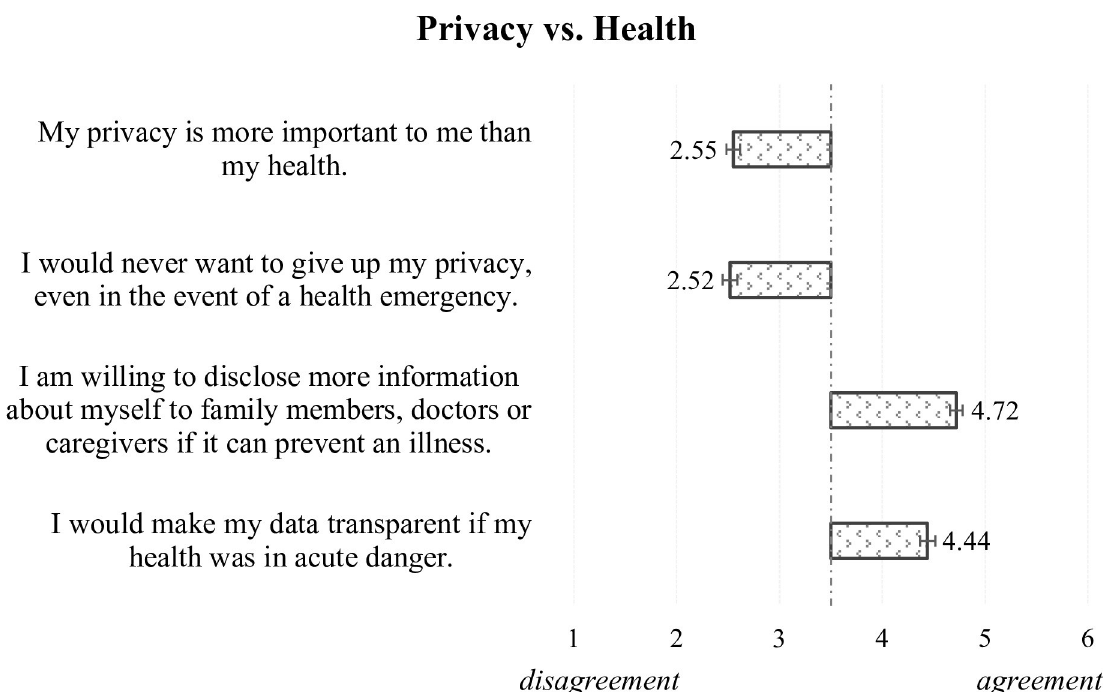
Fig 9. The relevance of health in the perception of privacy when using sensor-based technology.